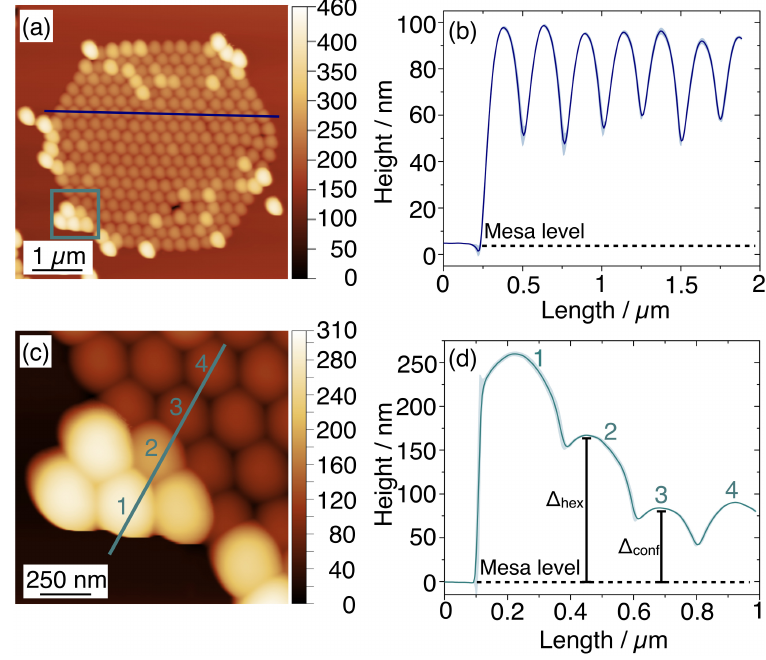
Figure 6. ( a ) AFM micrograph acquired on a hexagonal confining structure filled with a monolayer of NSs. The blue line marks the height profile in the line graph ( b ), where the shadowed region indicates the uncertainty of three repeated measurements. ( c ) The second AFM topographic image is acquired in the framed area in ( a ) and the line profile and numbered nanospheres are indicated. ( d ) The corresponding height profile reports nanosphere #2 is found at a higher level with respect from the mesa, ∆ hex = ( 167 ± 1 ) nm, with respect to NSs #3 and